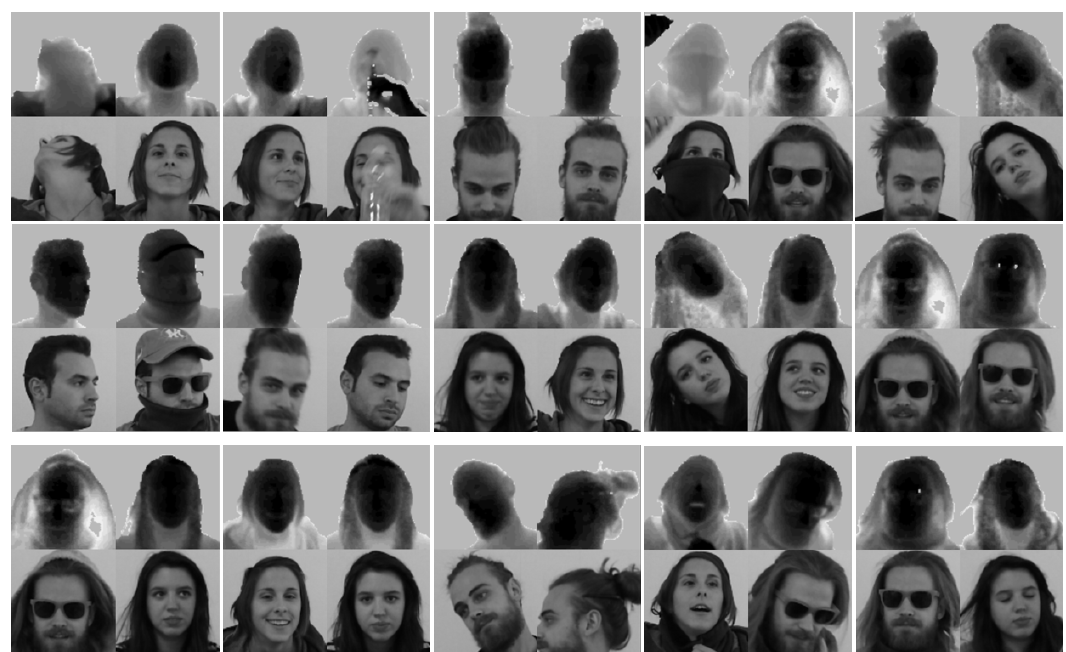
Figure 7. Sample output of the framework. From the top, the first block represents correct predictions, while wrong predictions are shown at the bottom. Depth maps are contrast stretched for a better visualization. Images were taken from the Pandora dataset.